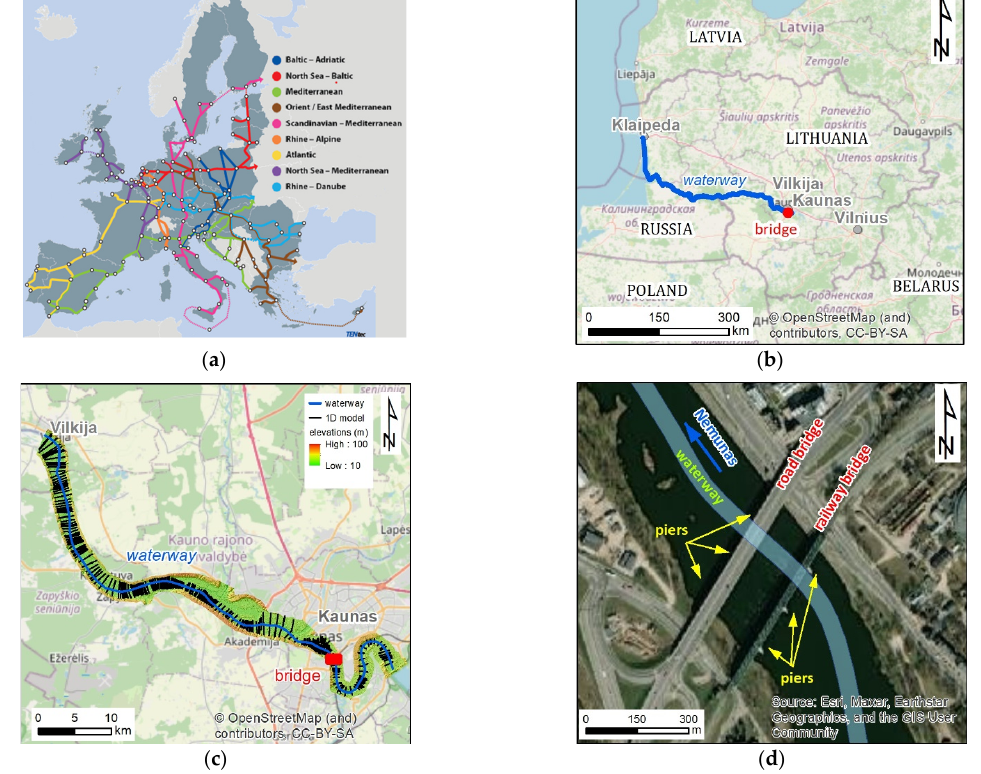
Figure 1. Location and elements of the investigated bridges: ( a ) TEN-T Core Network Corridors [42], ( b ) Kaunas-Klaipeda corridor and location of the bridge; ( c ) reach of the Nemunas Kaunas—Vilkija, ( d ) the bridge and its main elements.